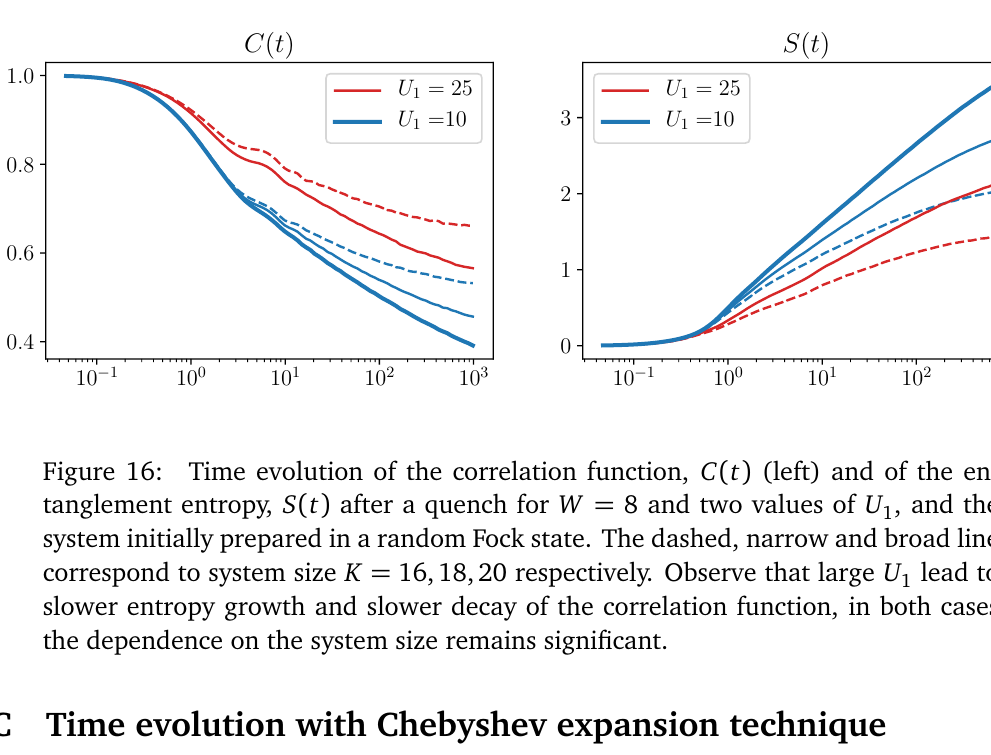
Time evolution of fermionic systems at half filling with K = 16 (and smaller) can be obtained easily by full exact diagonalization of the Hamiltonian matrix followed by exact calculation of the evolution operator U ( t ) for arbitrary time t